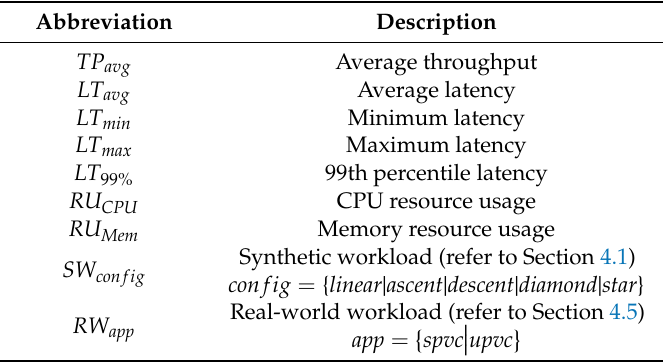
Table 2. Abbreviations for metrics and workload